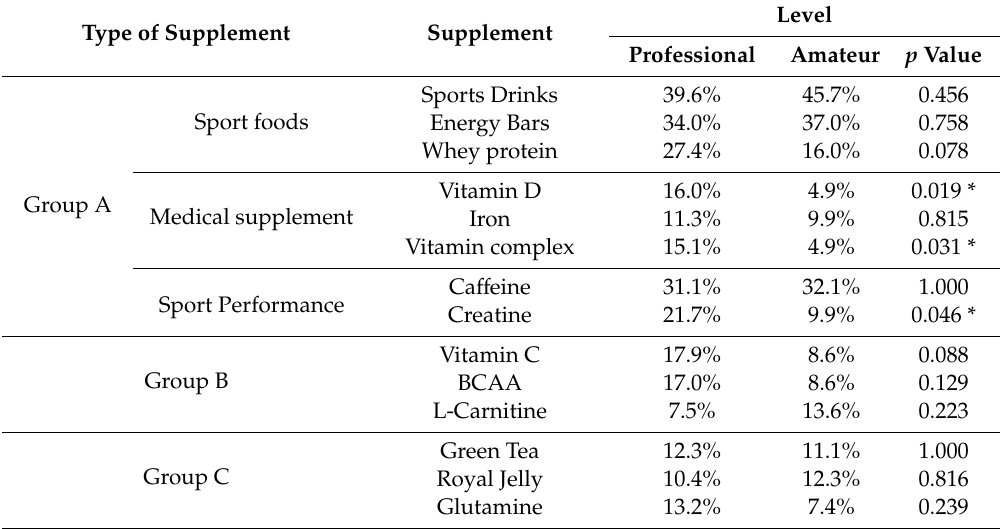
Table 4. Most-commonly used supplements according to competitive level in a sample of handball